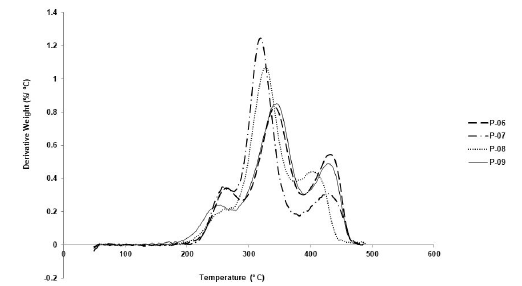
Figure 7. DTG curves of the copolymers P-06, P-07, P-08 and P-09.